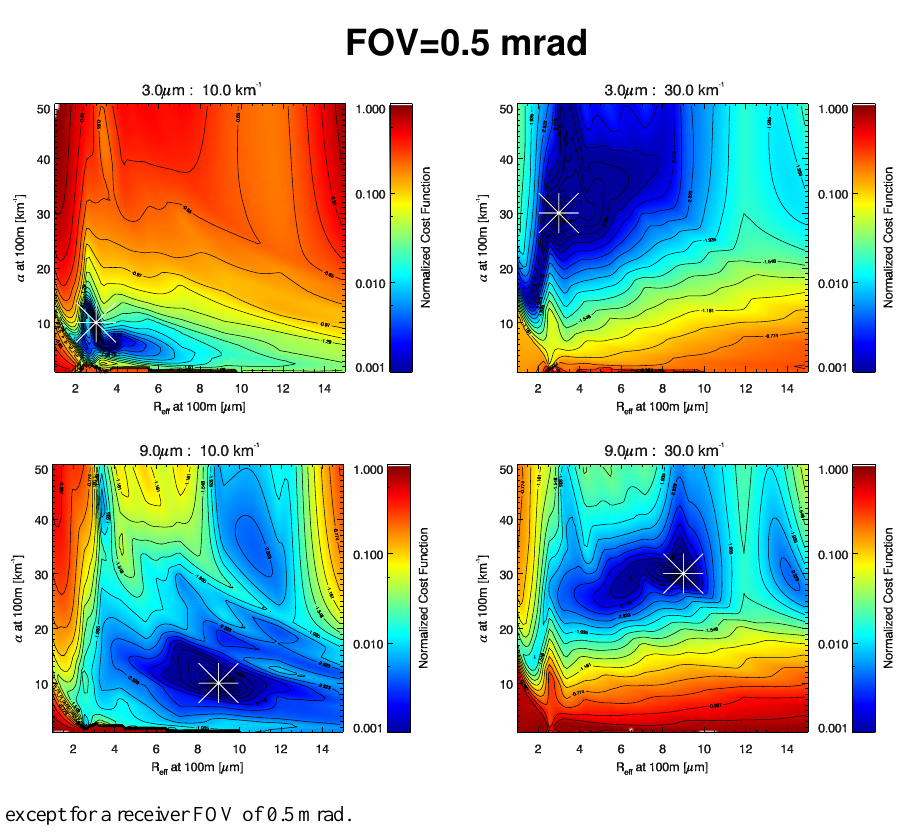
Figure 6. As Fig. 5 except for a receiver FOV of